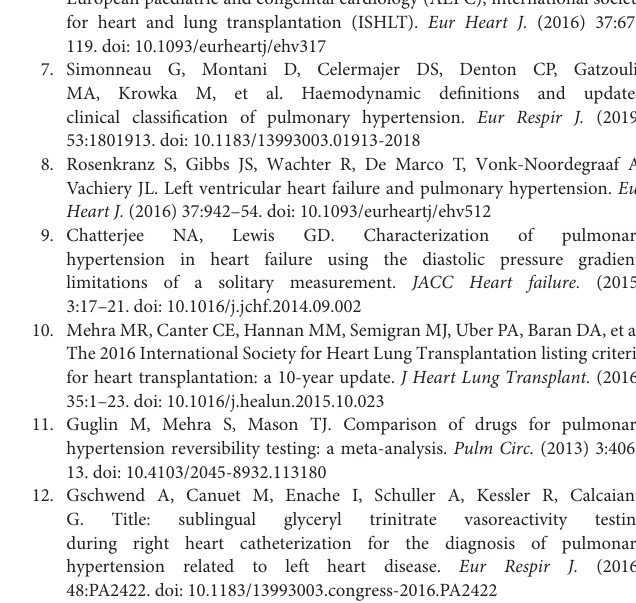
during right heart catheterization for the diagnosis of pulmonary hypertension related to left heart disease. Eur Respir J. (2016) 48:PA2422. doi: